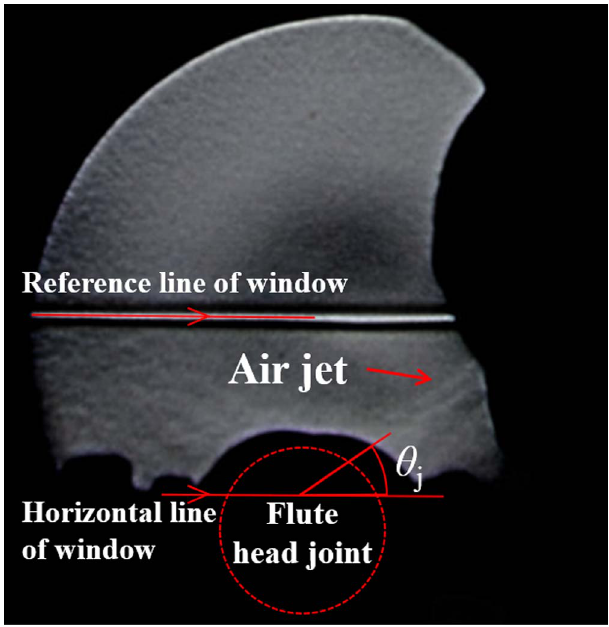
Figure 6. Jet visualization by Schlieren method.